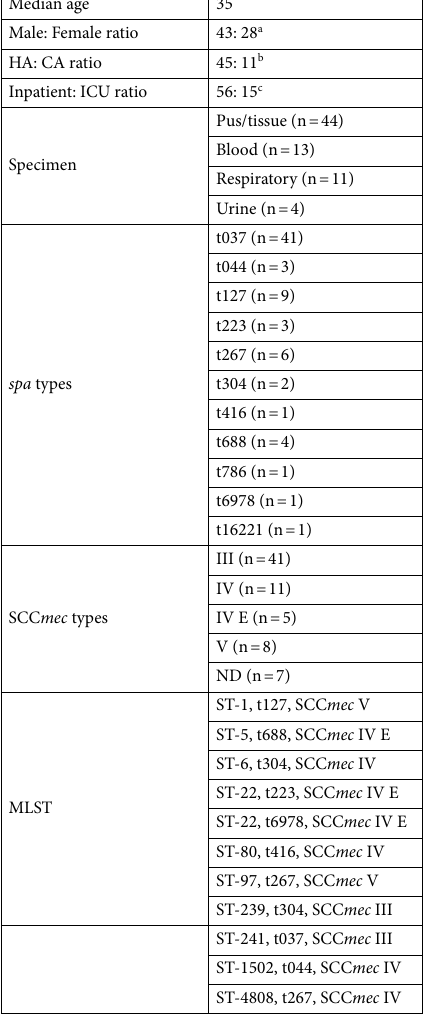
Table 1. Characteristics of 72 methicillin resistant Staphylococcus aureus isolates obtained from Alexandria Main University Hospital. a & c: gender and ward data were missing for one isolate. b: the date of admission and/or isolate collection was missing for 16 isolates.